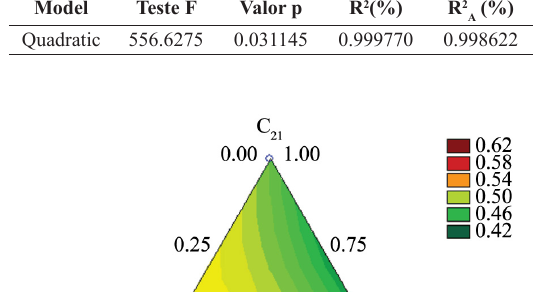
adsorption from MCM-41 2